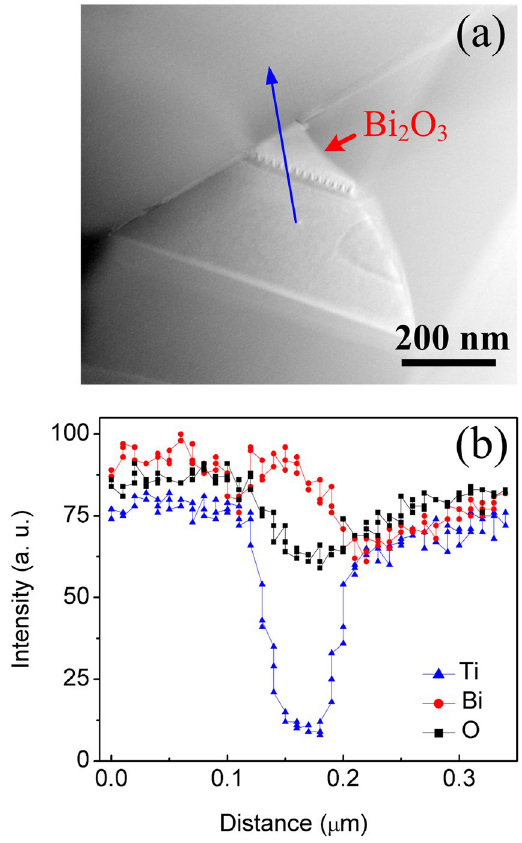
Figure 3. HAADF Z-contrast image showing Bi-rich phase (arrowed light areas) at the triple points in BiT-Bi. ( b ) EDS line scan across the Bi-rich phase in